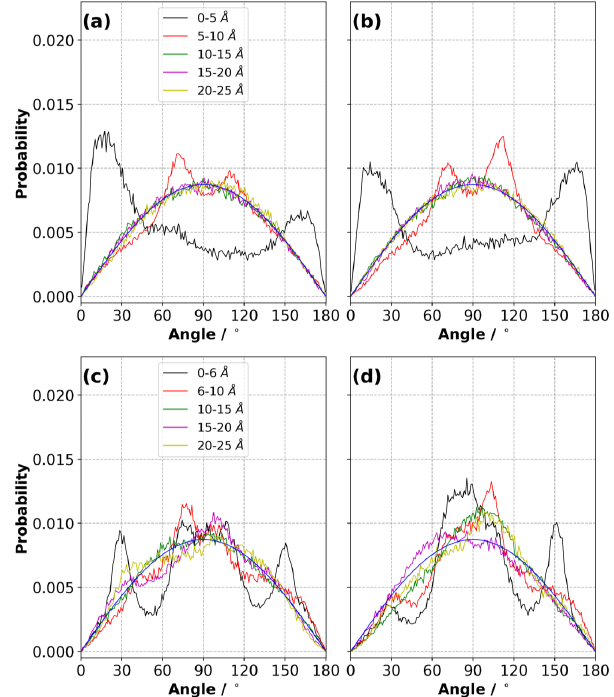
Figure 14. Angle distribution of [NTf 2 ] − ions in the layers (up to 20 Å from each electrode) for ( a ) Ψ − = 0 V, ( b ) Ψ + = 0 V in the [C 2 mim][NTf 2 ] IL, for ( c ) Ψ − = 0 V, ( d ) Ψ + = 0 V in the [N 4,1,1,1 ][NTf 2 ] IL at 294 K (averaged over three independently generated